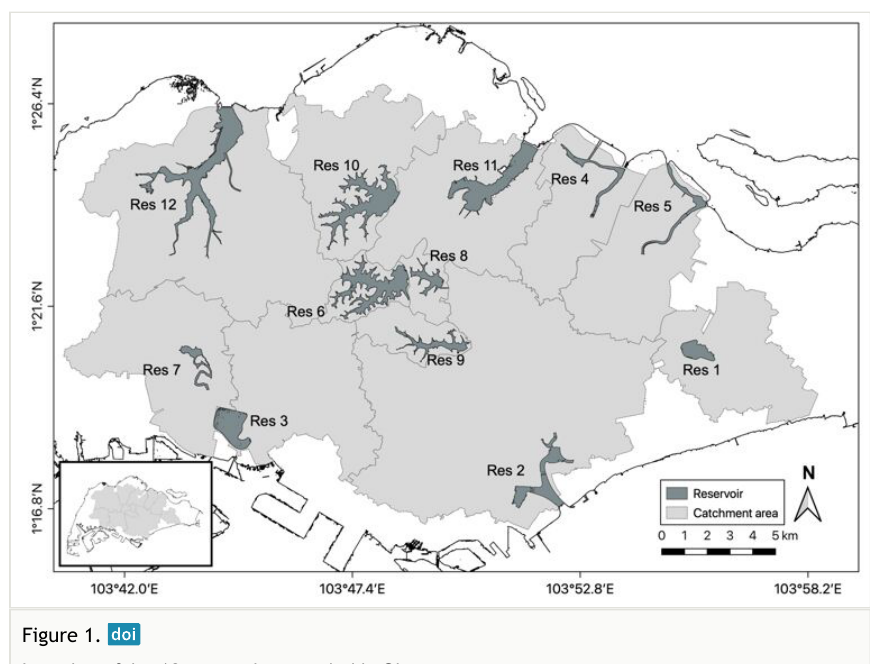
Figure 1. Location of the 12 reservoirs sampled in Singapore.